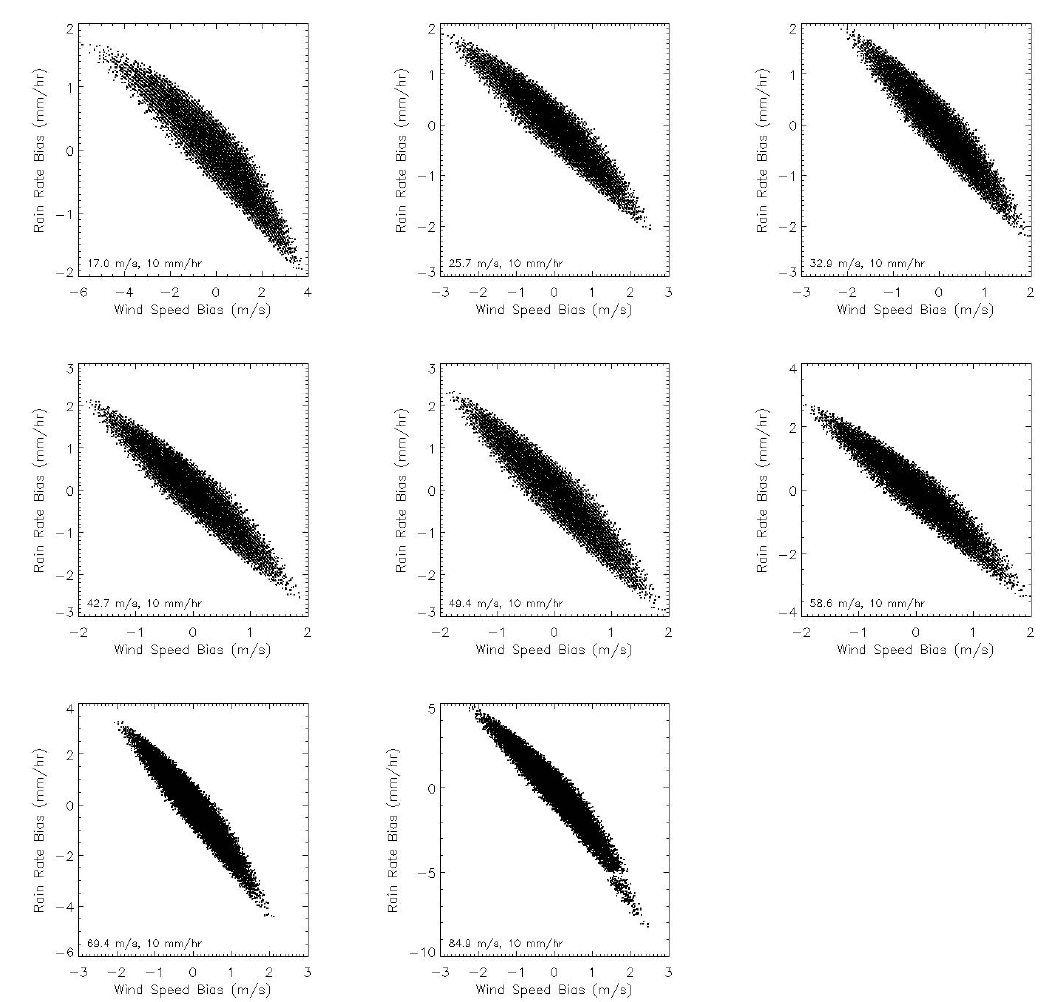
Figure 2. Rain-rate bias error versus the 10m ocean-surface wind-speed bias error with a true rain rate of 10mmh − 1 and the different wind conditions labeled in each panel. Each SFMR channel was allowed a tuning error of − 1.0, − 0.5, 0.0, 0.5 or 1.0K, resulting in 15,625 different cases for each wind